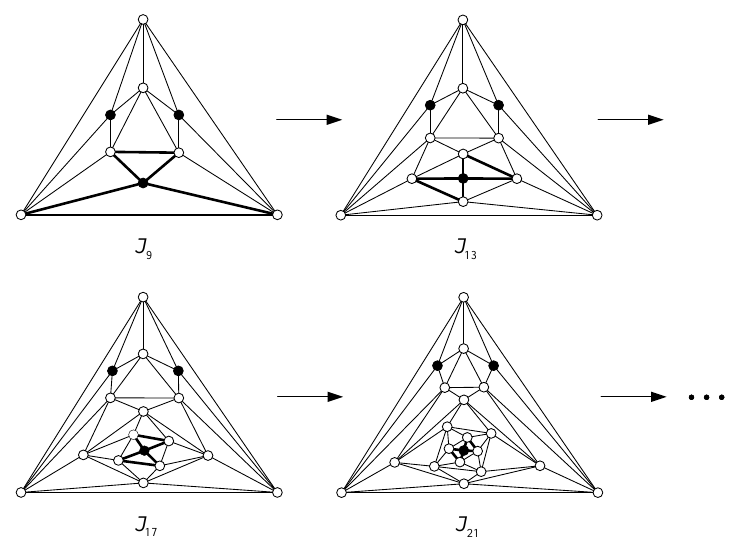
Figure 6. The schematic diagram of the generation process of I-dumbbell maximal planar